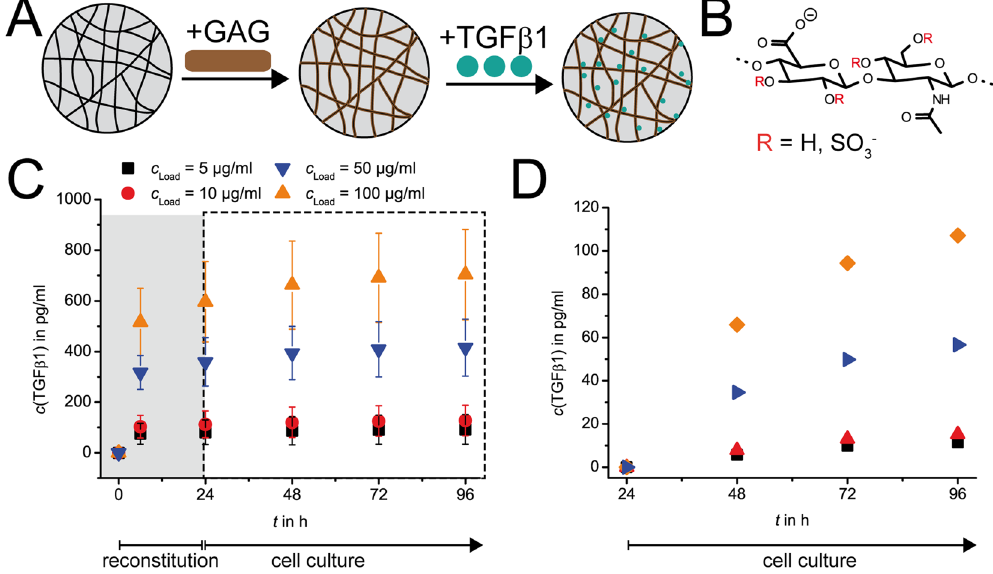
Figure 2. TGF β 1 is bound and released by µ -beads. ( A ) Modification of porous agarose µ -beads with GAG is achieved by reaction in presence of EDC, enabling formation of covalent bonds between GAG’s acidic groups and amine groups of µ -beads. The GAG provides binding sites for TGF β 1 adsorption. TGF β 1 adsorption is concentration dependent. Release is driven by a concentration difference between µ -beads’ interior and outside. ( B ) The GAG used in this study was medium-sulfated hyaluronan (msHA). The degree of sulfation is about 2 sulfate groups per disaccharide unit of the GAG and therefore similar to heparin. Possible positions of sulfate groups are marked with red ‘R’. ( C ) Release kinetics of TGF β 1 as determined by ELISA. Concentration of TGF β 1 was measured in the supernatant released from 10 4 µ -beads. The depicted release curve is already re- calculated for cell culture conditions. It shows concentration increase of TGF β 1 in the supernatant delivered by 500 µ -beads. Released concentrations correlate with loading concentrations. The area shaded in grey (first 24 h) covers so-called “initial burst” of TGF β 1. This amount is washed out before cell culture experiments by repeated rinsing of collagen networks before seeding fibroblasts. ( D ) Increase of TGF β 1 concentration in the medium during cell experiments starting after cell seeding. The released concentration of TGF β 1 release over 24 h was subtracted. Release curves show TGF β 1 delivered by 500 µ -beads over 3 d from day 1 until day